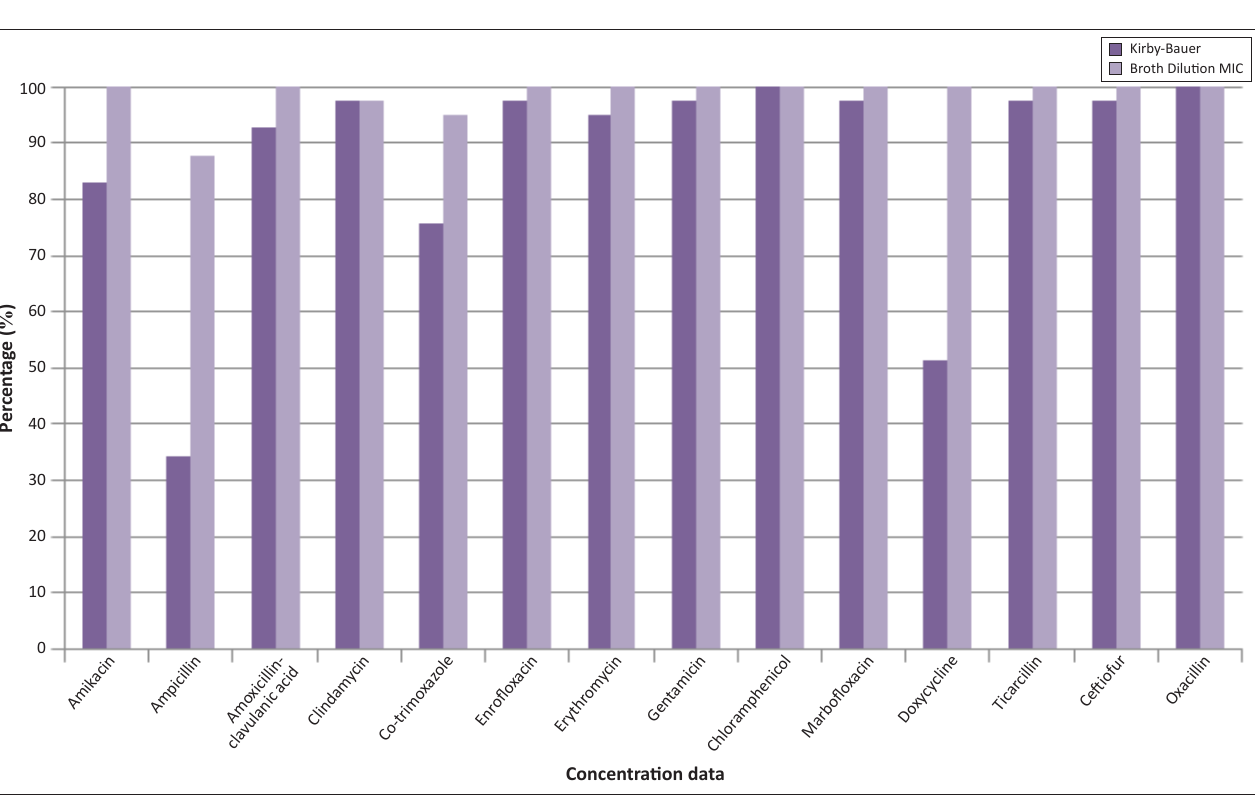
FIGURE 2: Comparison of percentage antimicrobial susceptibility as indicated by Kirby–Bauer and broth dilution minimum inhibitory concentration data for the period